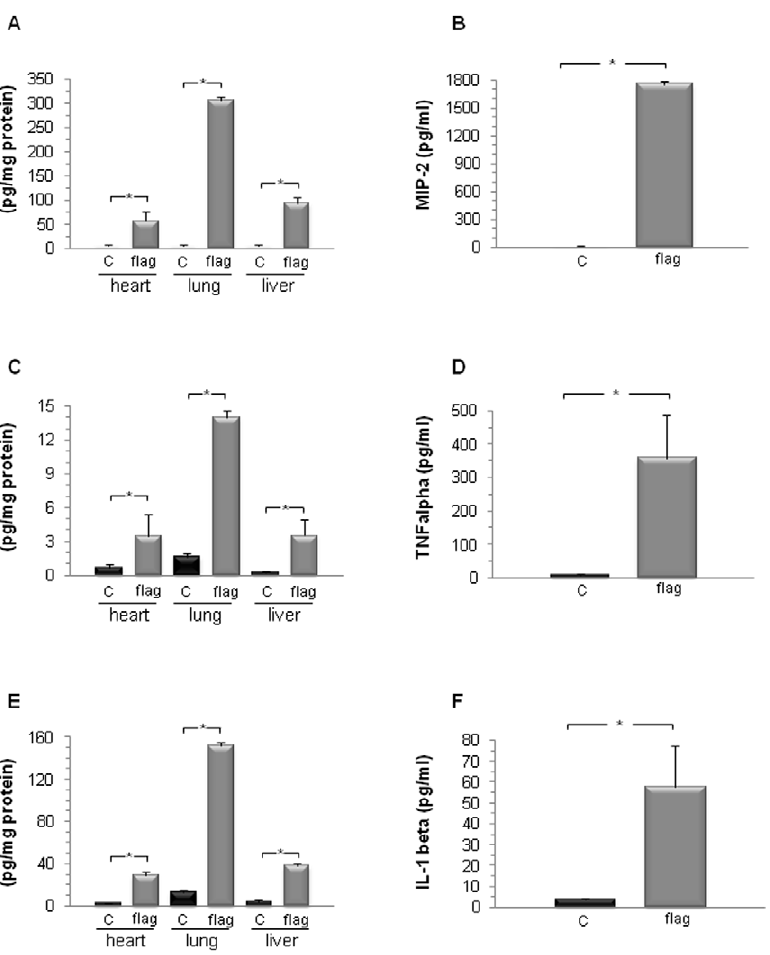
Figure 8. Flagellin induces widespread generation of pro-inflammatory cytokines. The levels of MIP-2 (A, B), TNF a (C, D) and IL-1 b (E, F) were determined by ELISA in the lung and liver (left panel) as well as in plasma (right panel) in control (C) and 1 h after systemic flagellin administration (n=3mice/group). A significant increase of these cytokines was detected both in organs and in plasma. *p , 0.05 vs control C (t test).